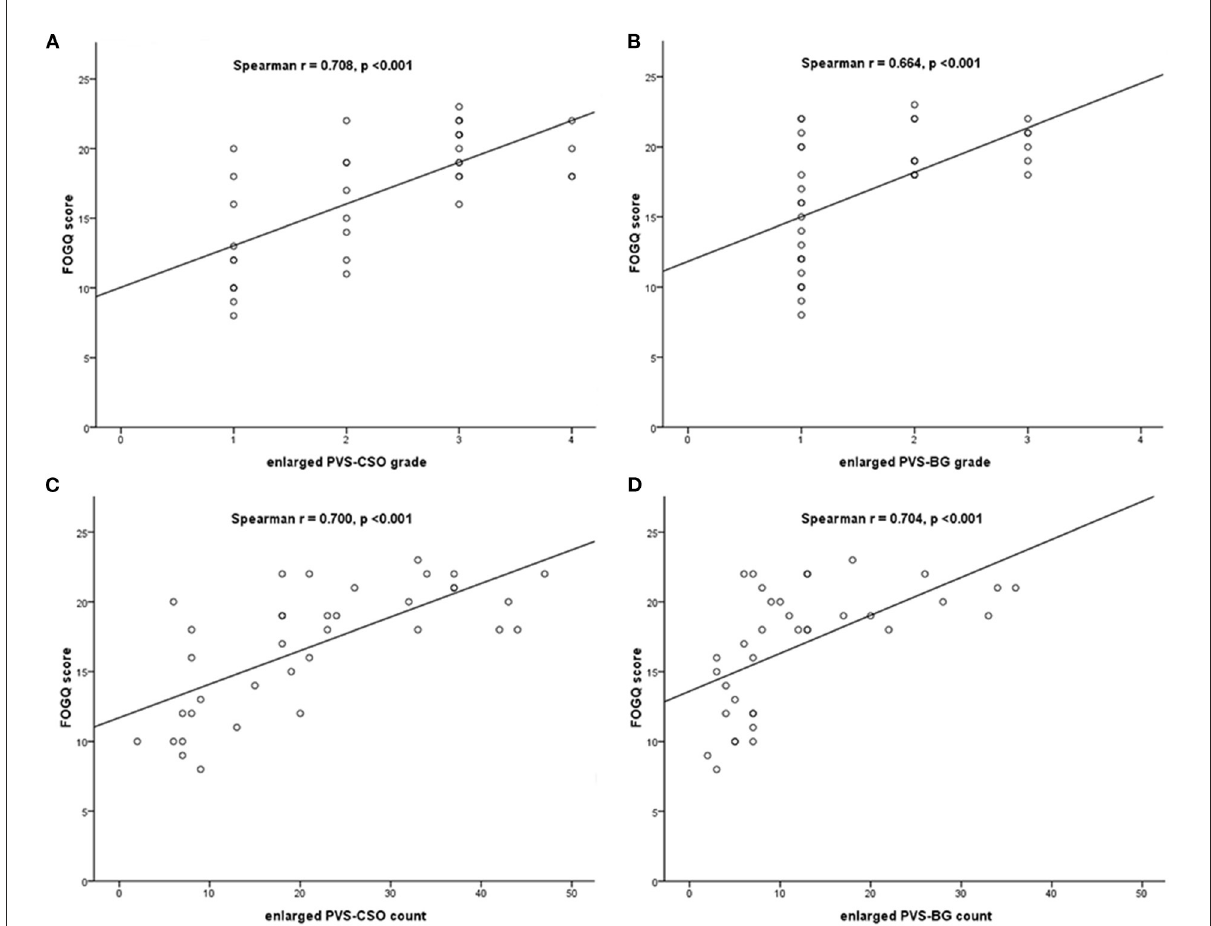
FIGURE2 Spearman’s correlation between the enlarged PVS and FOGQ score in PD patients with FOG. (A) Correlation between enlarged PVS-CSO grade and FOGQ score. (B) Correlation between enlarged PVS-BG grade and FOGQ score. (C) Correlation between enlarged PVS-CSO count and FOGQ score. (D) Correlation between enlarged PVS-BG count and FOGQ